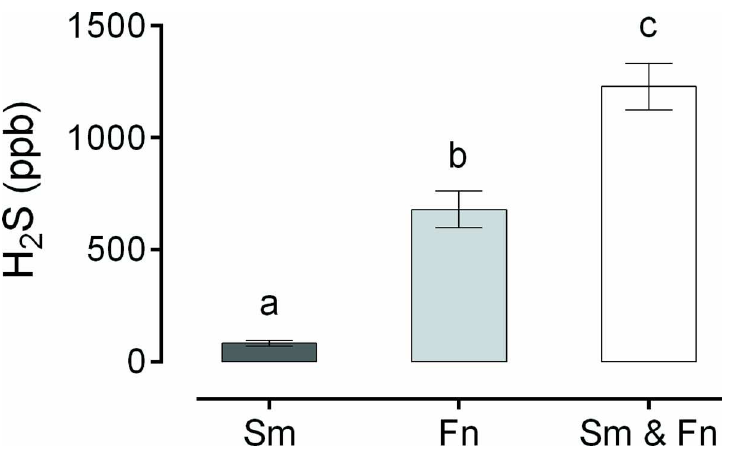
Fig 4. Means and standard deviations for the in vitro production of H 2 S (ppb) by S . moorei (Sm), F . nucleatum (Fn) and the H 2 S production by Sm and Fn when they were grown together (Sm & Fn). Different letters indicate statistically significantdifferencesbetweengroups (ANOVA and Tukey’s test, p <